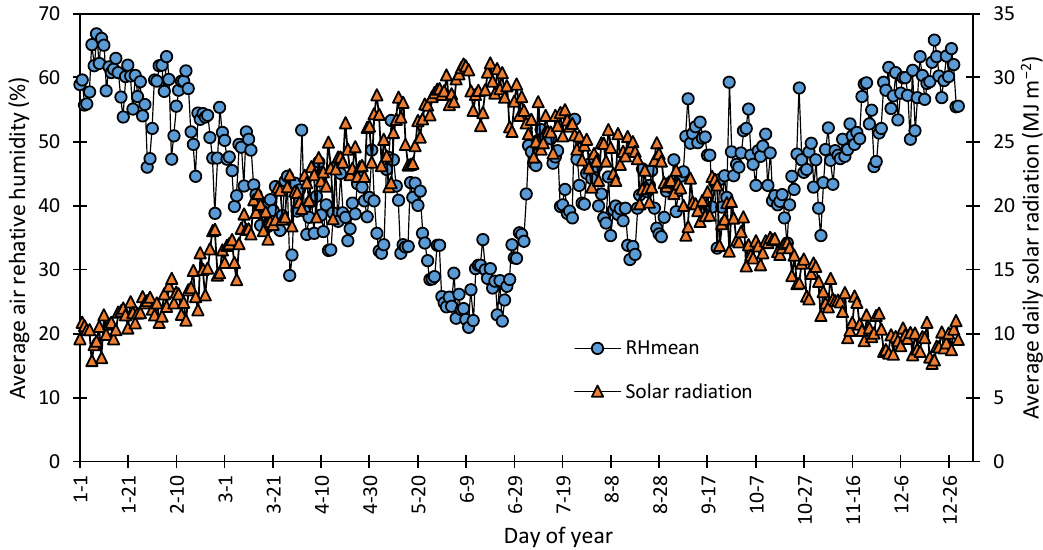
Figure 2. Trend in the daily average relative humidity and solar radiation for 2003–2019 period at the Agricultural Science Center at Farmington, New Mexico.